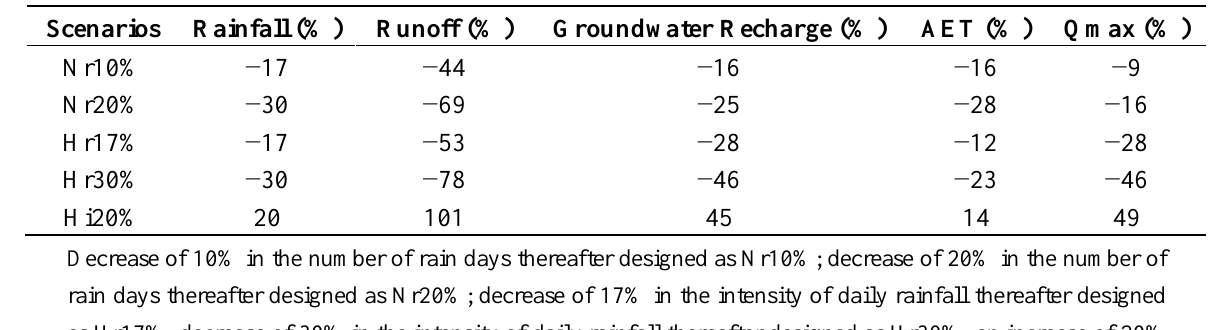
Table 2. Relative variations of the hydrological components with ORCHIDEE (ORganising Carbon and Hydrology In Dynamic EcosystEms) under the five scenarios of the changes in rainfall